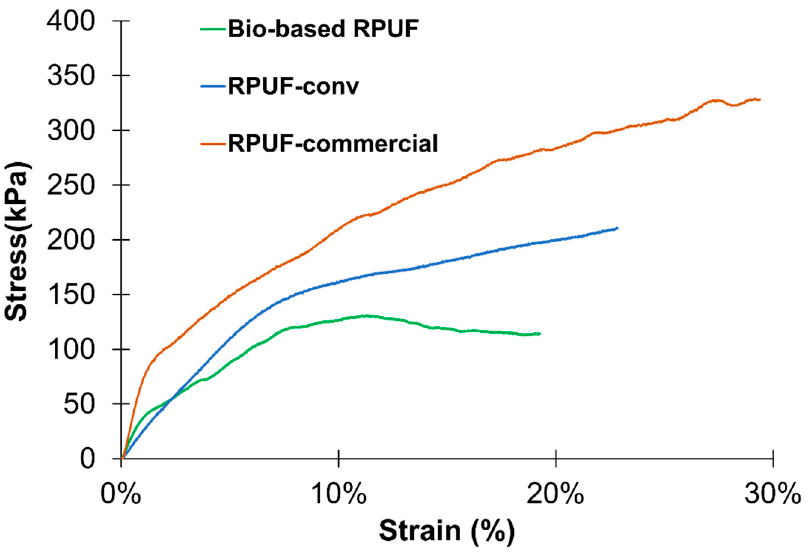
Figure 3. Compressive stress − strain curves of bio − based RPUF, RPUF − conv, and RPUF − commer- cial.